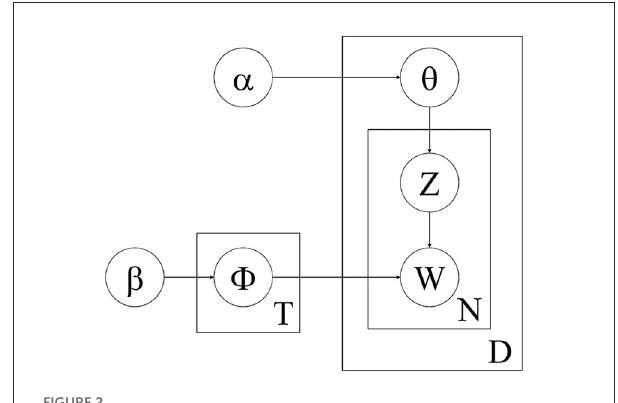
FIGURE2 Topic generation principle of the LDA